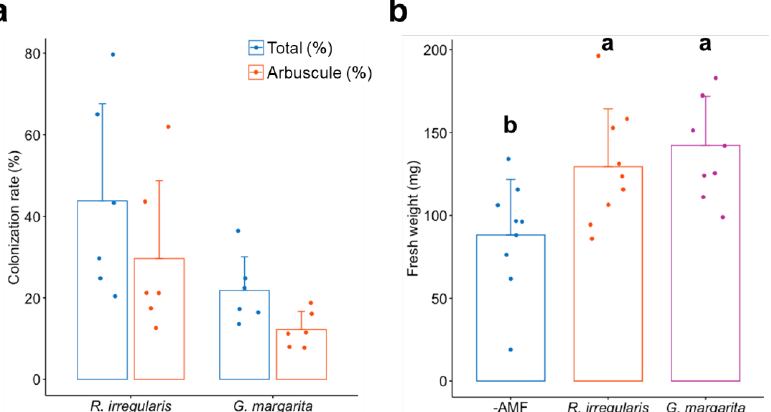
Figure 2. Quantification of AM fungal colonization rates and AM-promoted shoot growth of tomato plants. ( a ) The fungal colonization rates of Rhizophagus irregularis or Gigaspora margarita in tomato roots at five weeks post-inoculation (wpi). Total (%), the percentage of all hyphal structures observed in the tomato roots; arbuscule (%), the rate of arbuscules formed in the cortical cells. There is no in Welch’s t -test. The error bars show the standard errors (n = 6). ( b ) The shoot fresh weight of tomato colonized by R. irregularis and G. margarita at five wpi. AMF, non-colonized tomato roots; R. irregularis, R. irregularis -colonized roots; G. margarita , G. margarita -colonized roots. The bars and dots indicate the average and individual values, respectively. The error bars indicate the standard errors (n = 9). The different letters indicate statistical significance ( p < 0.05) in analysis of variance (ANOVA) with a post hoc Tukey-Kramer